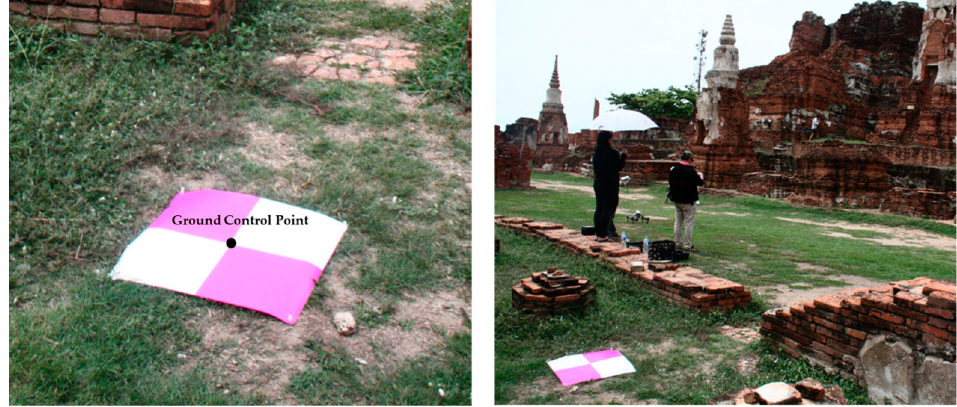
Figure 4. Ground control points (GCPs) designed in a white and pink pattern.